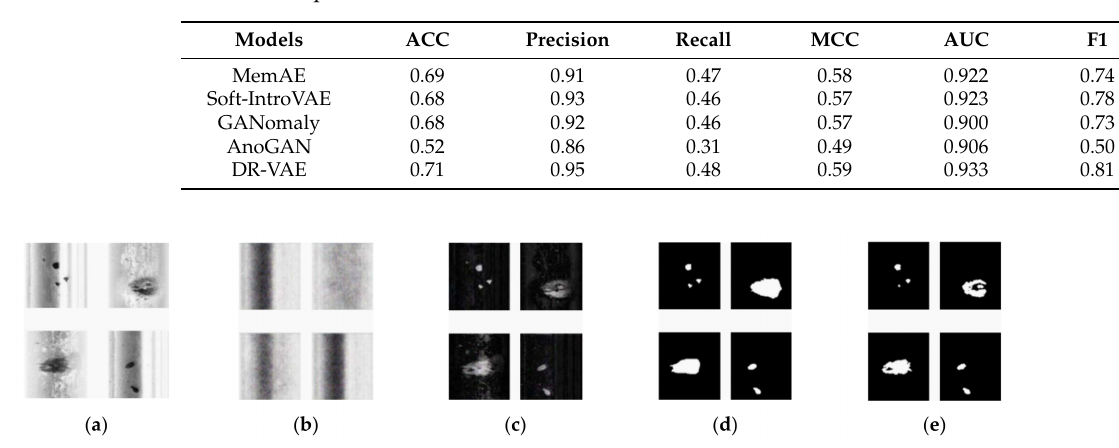
Table 3. Comparison of different rail surface defect detection methods.